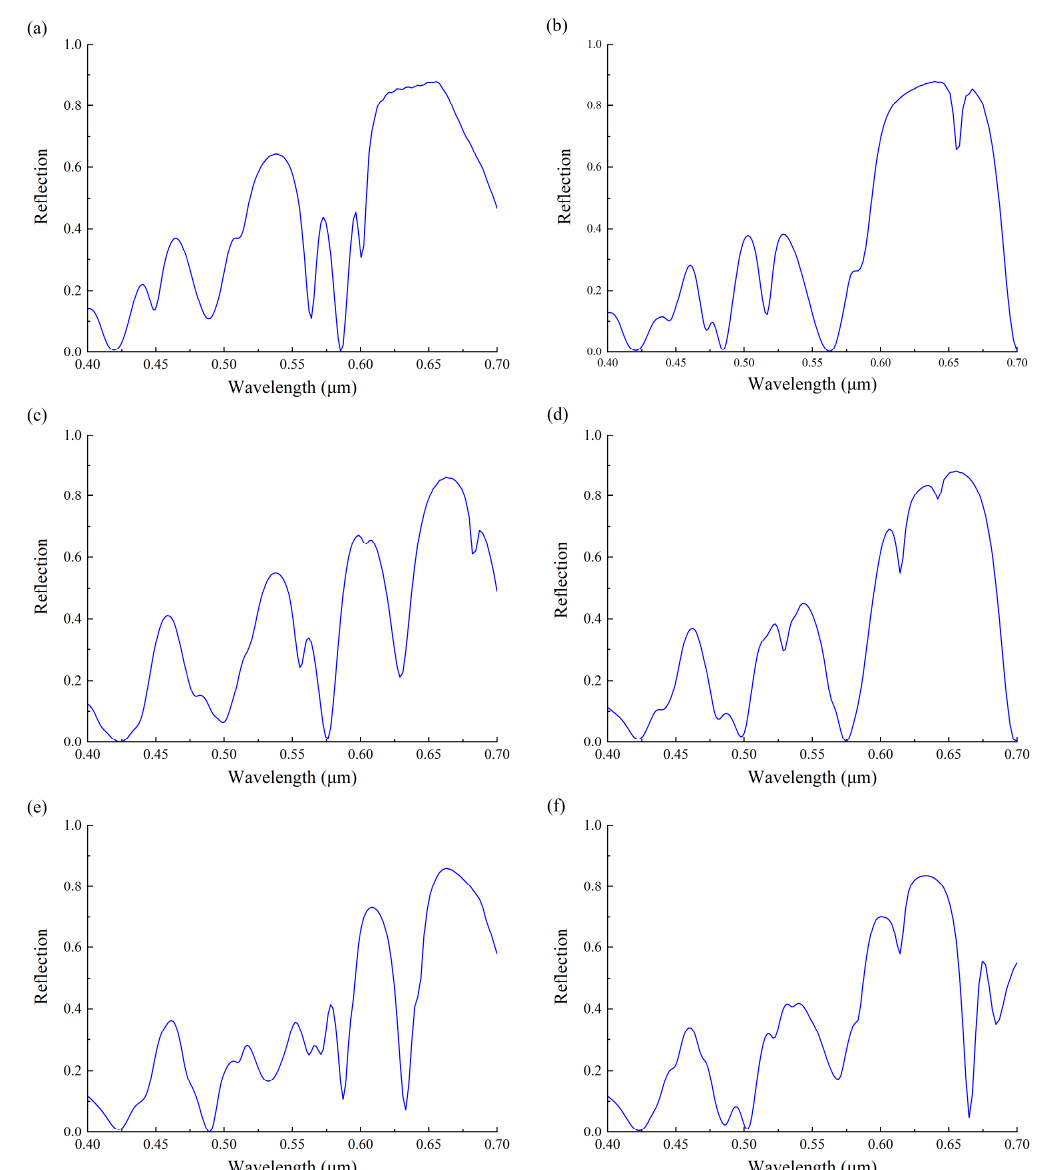
Figure 7. The reflection spectra of different H s . ( a ) The reflection spectra with H s = 100 nm. ( b ) The reflection spectra with H s = 140 nm. ( c ) The reflection spectra with H s = 170 nm. ( d ) The reflection spectra with H s = 230 nm. ( e ) The reflection spectra with H s = 270 nm. ( f ) The reflection spectra with H s = 300 nm.